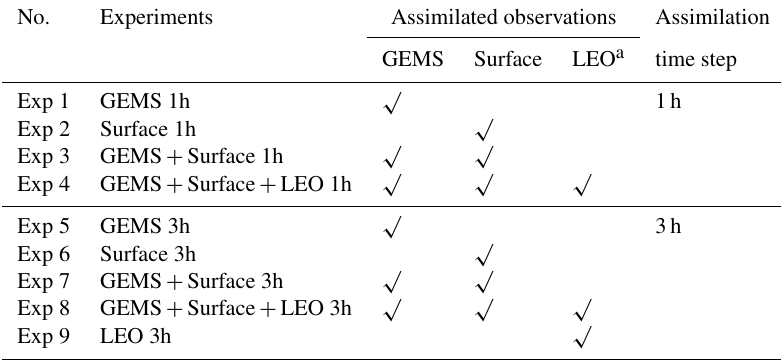
GEMS Surface LEO a time step √ 1h √ √ √ √ √ √